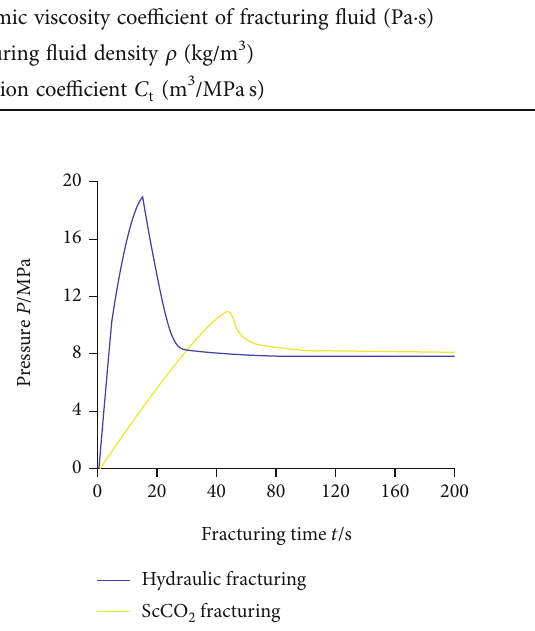
Figure 14: Fracturing pressure over time for hydraulic and ScCO 2 fracturing numerical simulation of coals based on